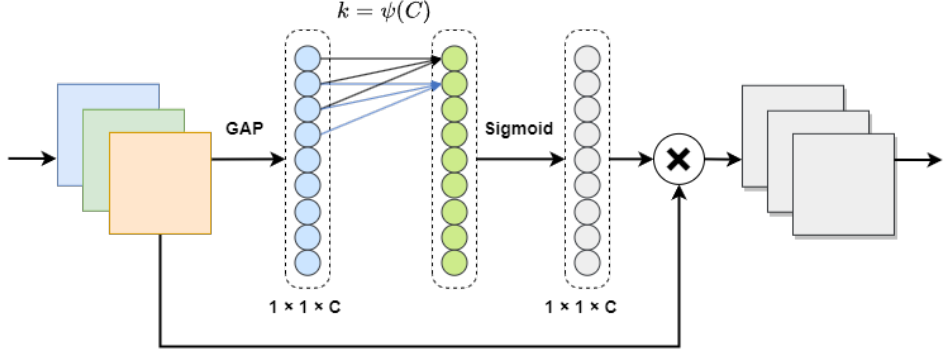
Figure 2. The structure of the ECA